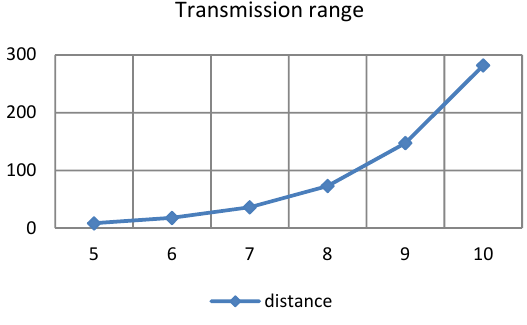
Fig. 11: The transmission range for λ = 1 meter.